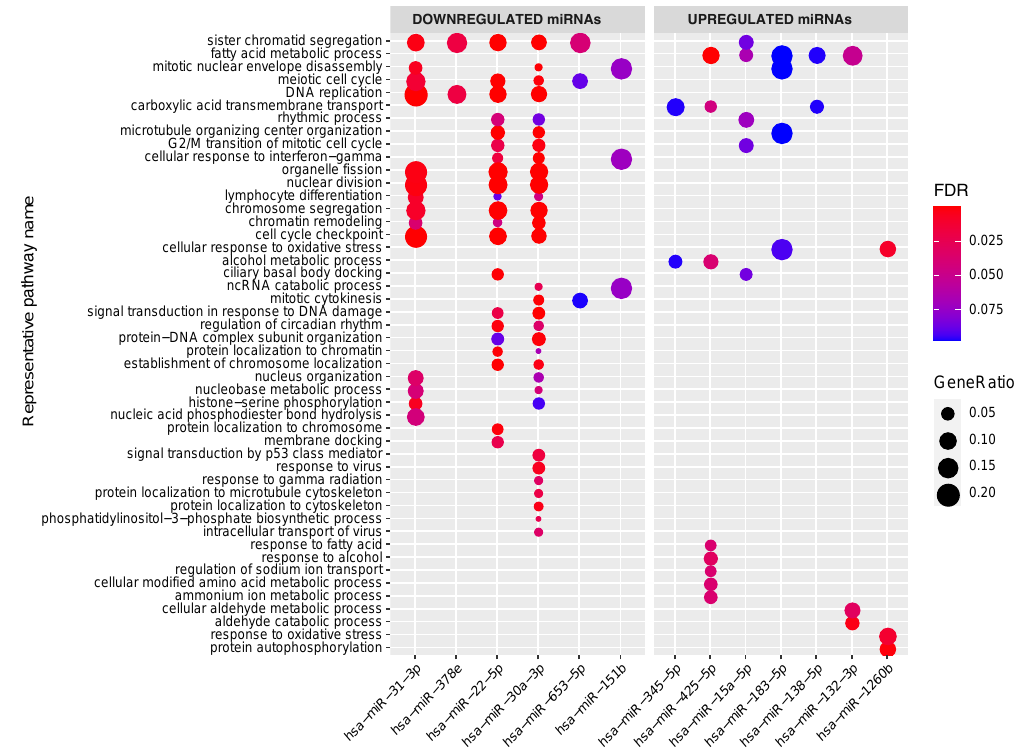
Figure 4. Enrichment of the target genes associated with the individual miRNAs in the miRNA–target transcript network. Y-axis shows representative GO terms that summarize the groups of GO terms selected by REVIGO (input: all the GO terms of the miRNAs combined). miRNAs are sorted from lowest fold change (miR-31) to highest fold change (miR-1260b) in the CeD versus controls comparison. The significance of the enrichment is indicated in FDR by the colorscale and the GeneRatio is indicative of the ratio of genes targeted by the miRNA and the total number of genes in the